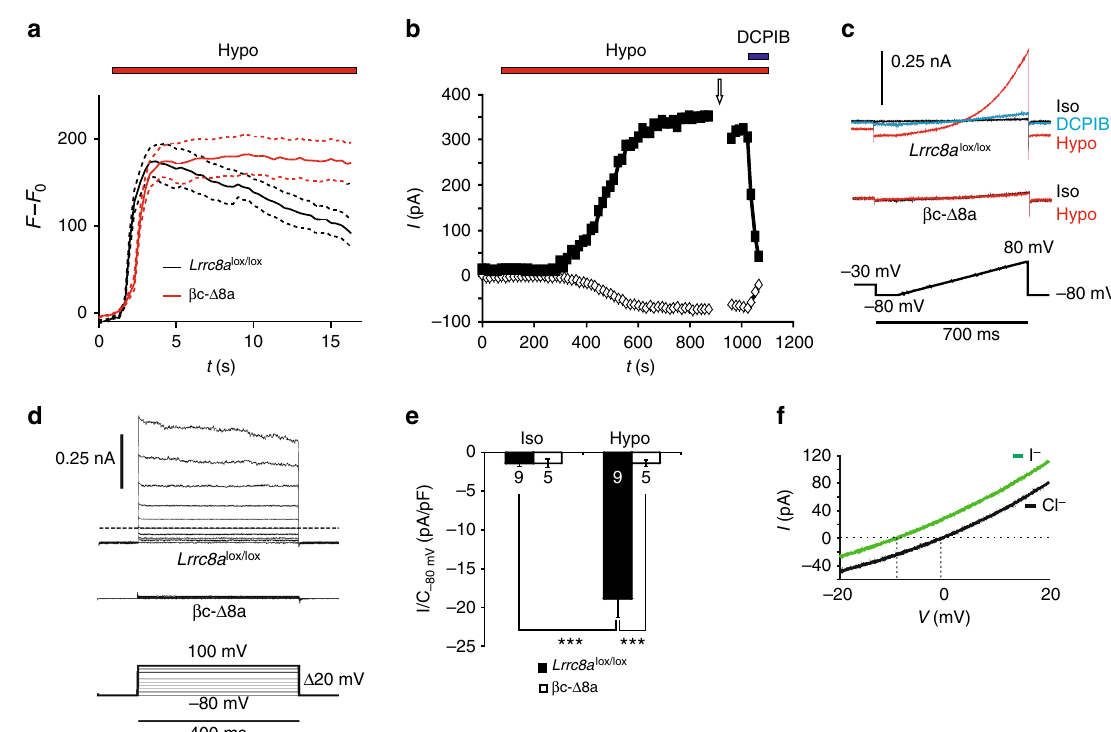
Fig. 2 Hypotonicity-induced cell swelling and VRAC currents in mouse β -cells. a Cell volume as monitored in individual β -cells using calcein fl uorescence. The extracellular isotonic solution was replaced by a 30% hypotonic solution (210 mOsm) during the time indicated by the bar. Averaged curves ± SEM (dotted lines), n = 16 and n = 18 for Lrrc8a lox/lox and β c- Δ 8a β -cells, respectively. Data are representative of three independent experiments. b Representative time course of I Cl,vol of an isolated primary β -cell provoked by superfusion with hypotonic solution (240 mOsm) without or with 20 µ M DCPIB as indicated. Currents elicited at − 80 to 80 mV by voltage ramps (see c ) are plotted. c Typical current-voltage ( I – V ) curves of hypotonicity- provoked I Cl,vol elicited by the ramp protocol shown below, from indicated genotypes and conditions. d Representative current traces obtained with the voltage step protocol shown at bottom. The upper traces show control ( Lrrc8 lox/lox ) currents after full activation of I Cl,vol , taken at the time indicated